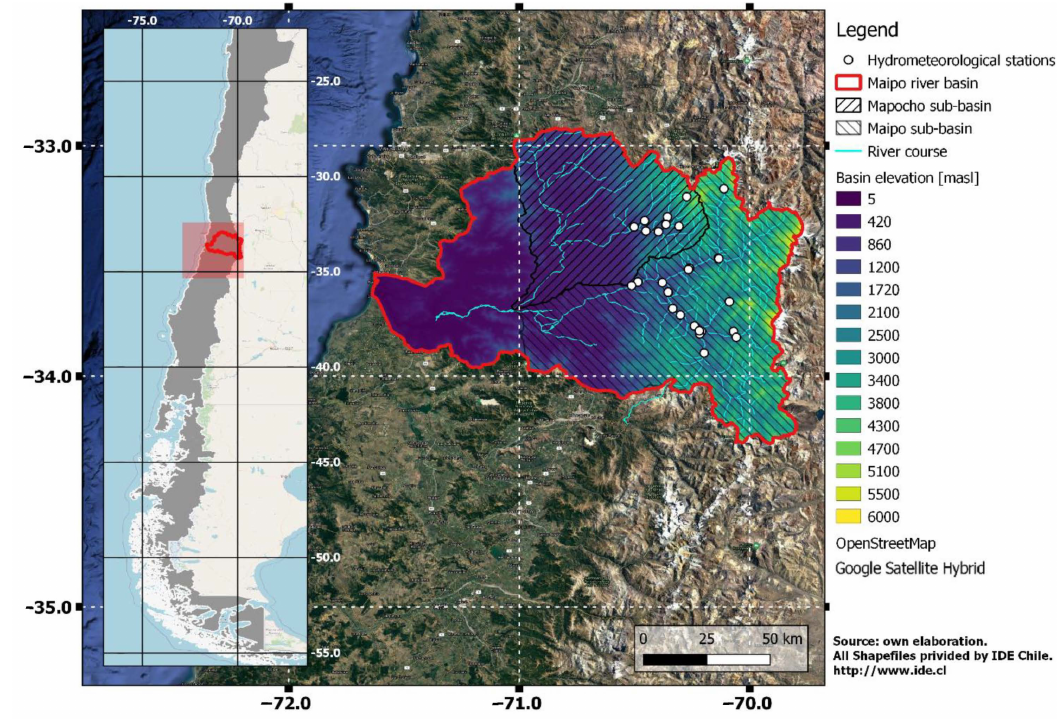
Figure 1. Study area in the Maipo basin in the Central-Western Andes.